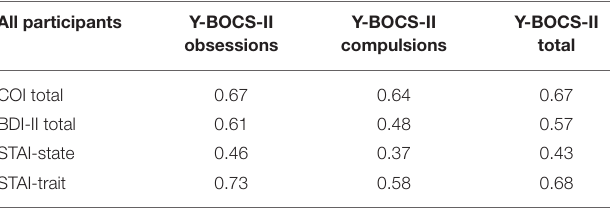
TABLE 3 | Correlations between psychometric measures and Y-BOCS-II partial and total score in all participants. All participants Y-BOCS-II Y-BOCS-II Y-BOCS-II obsessions compulsions total COI total 0.67 0.64 0.67 BDI-II total 0.61 0.48 0.57 STAI-state 0.46 0.37 0.43 STAI-trait 0.73 0.58